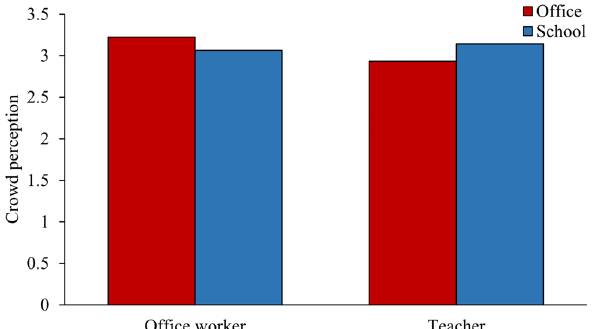
Figure 6. The effect of building × occupation interaction on participants’ perceptions of other occupants.